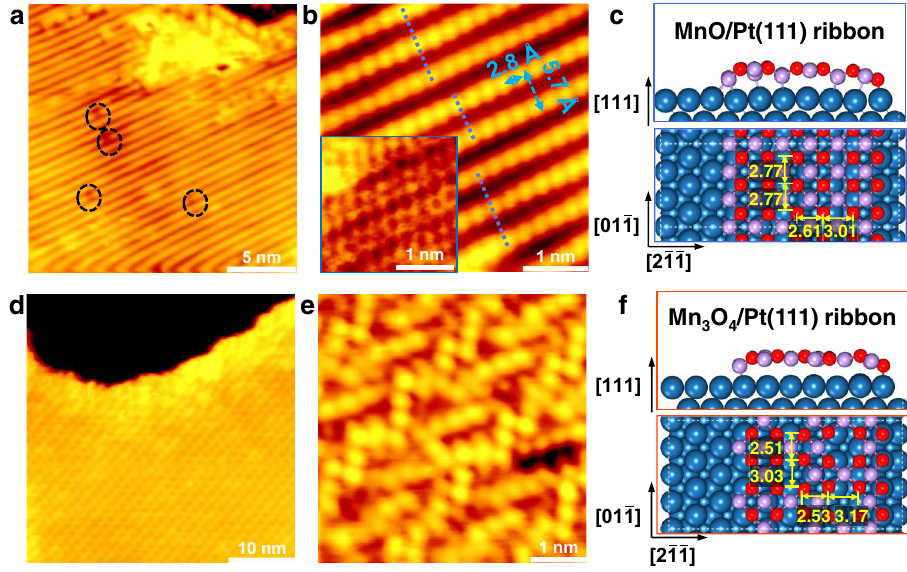
Fig. 1 | STM images and proposed models of manganese oxides on Pt(111). a STM image of as-prepared stripe-like MnO(001)/Pt(111) surface. b Atomic cor- rugation of stripe-like MnO(001) and the inset in ( b ) shows the atomic-resolution STMimageofthesurface. c A(6×3)MnOribbonsupportedonthe(5 √ 3×3)Pt(111) substrate, which is equivalent to a moiety from the reported (19×1) reconstruc- tion. The orthogonal MnO monolayer can be truncated along the rock-salt MnO(001) surface. d STM image of as-prepared grid-like Mn 3 O 4 (001)/Pt(111) sur- face. e Atomic-resolution STM image of the grid-like Mn 3 O 4 (001). f An Mn 3 O 4